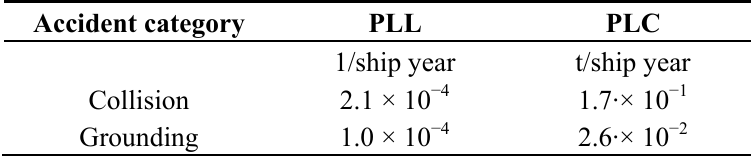
Table 3. Summary of characteristic risks for one design variant and for human and environmental